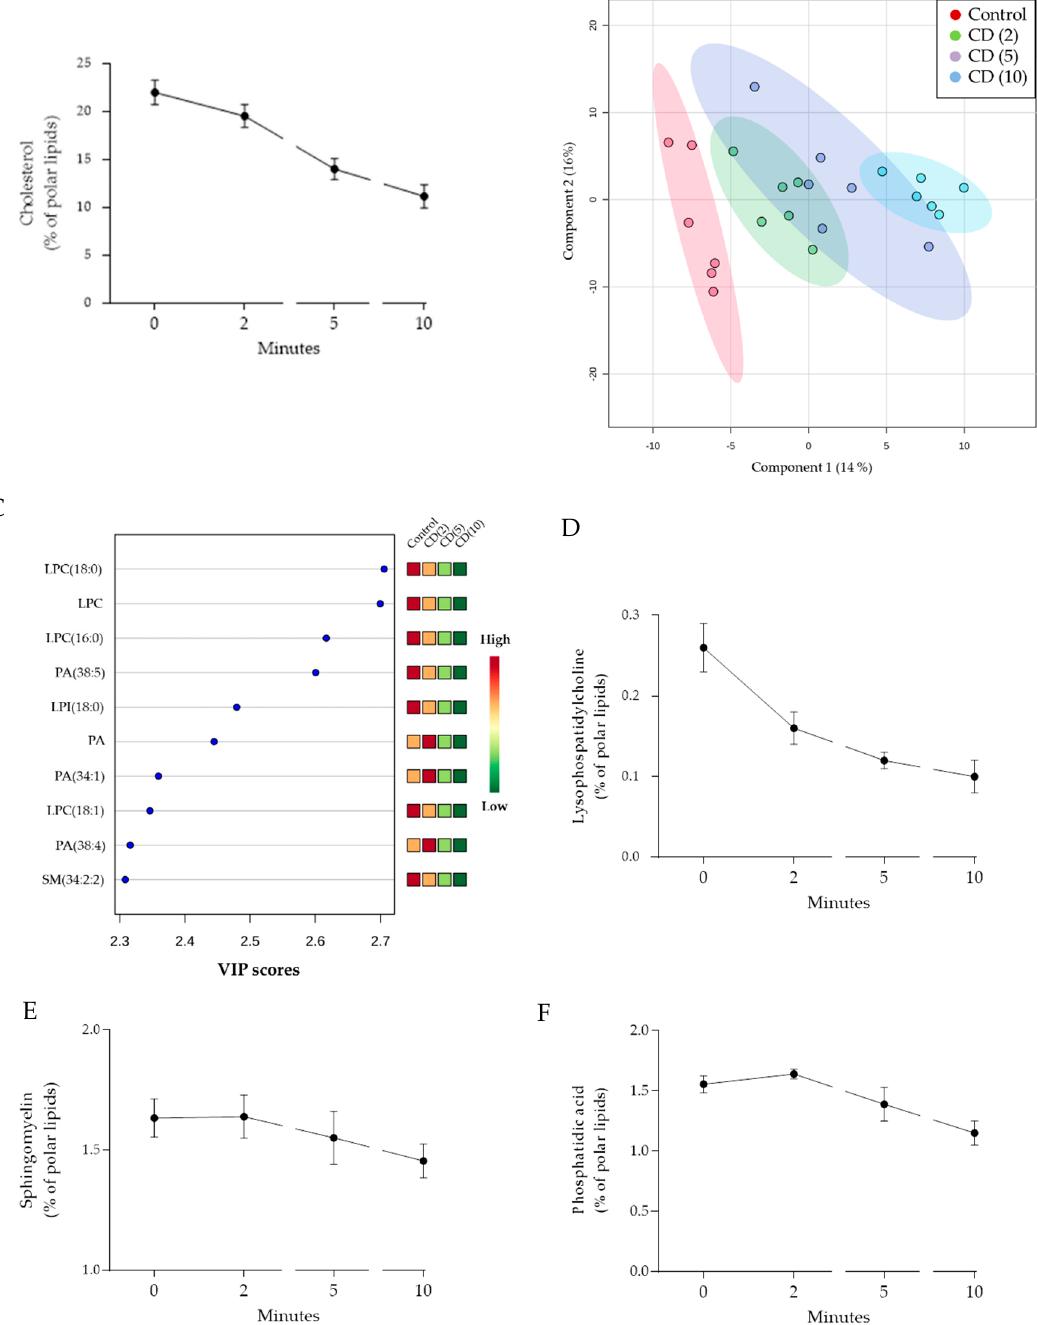
Figure 4. Effect of M β CD on B16-F10 lipidome. ( A ) Time-dependent changes in the levels of cholesterol; ( B ) PLS-DA scores plot generated without cholesterol values; ( C ) Most important discriminative features due to M β CD treatment: lysophosphatidylcholine (LPC), phosphatidic acid (PA), lysophosphatidylinositol (LPI), sphingomyelin (SM); Time-dependent changes in the levels of lysophosphatidylcholine ( D ), sphingomyelin ( E ), and phosphatidic acid ( F ). CD (X): cells exposed for 2, 5, or 10 min to M β CD.